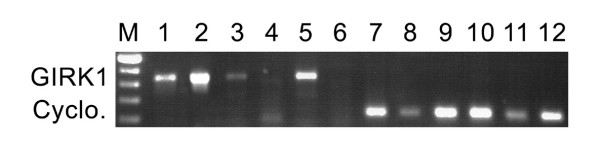
Agarose gel showing expression of mRNA for GIRK1 in human breast cancer cell lines by RT-PCR. The GIRK1 primers amplified a 441-bp fragment whereas the cyclophylin primers amplified a 216 bp fragment. For each cell line, a negative control reaction without M-MLV reverse transcriptase was performed and found to be negative. Lanes 1 & 7, ZR-75-1; Lanes 2 & 8, MCF-7; Lanes 3 & 9, MDA-MB-361; Lanes 4 & 10, MDA-MB-435S; Lanes 5 & 11, MDA-MB-453; Lanes 6 & 12, MDA-MB-468, Lane M, a 100 bp marker. PCR reactions resolved on this gel were in the plateau phase of PCR, therefore concentrations of PCR amplified cDNA samples cannot be compared.